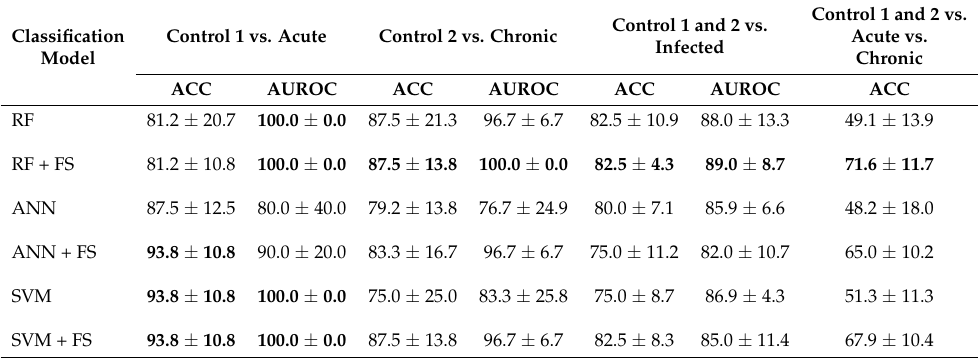
Table 3. Cross-validation results (mean ± standard deviation). The best classification results presented in bold, where all performances are shown as a percentage (%).